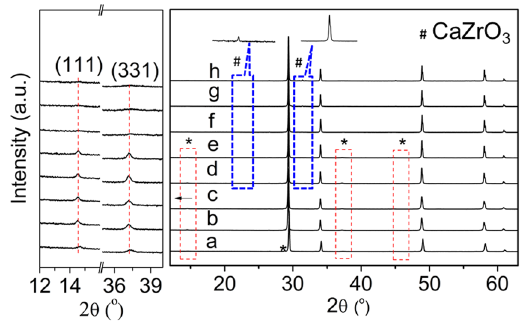
Figure 1. XRD patterns of Gd 2 − x Ca x Zr 2 O 7 + δ powders calcined at 1500 °C for 4 h: (a) x = 0, (b) x = 0.02, (c) x = 0.05, (d) x = 0.1, (e) x = 0.15, (f) x = 0.2, (g) x = 0.25, (h) x = 0.3. Left insert shows an enlargement of some areas of the XRD patterns. The symbol “ * ” represents the superstructure peaks.